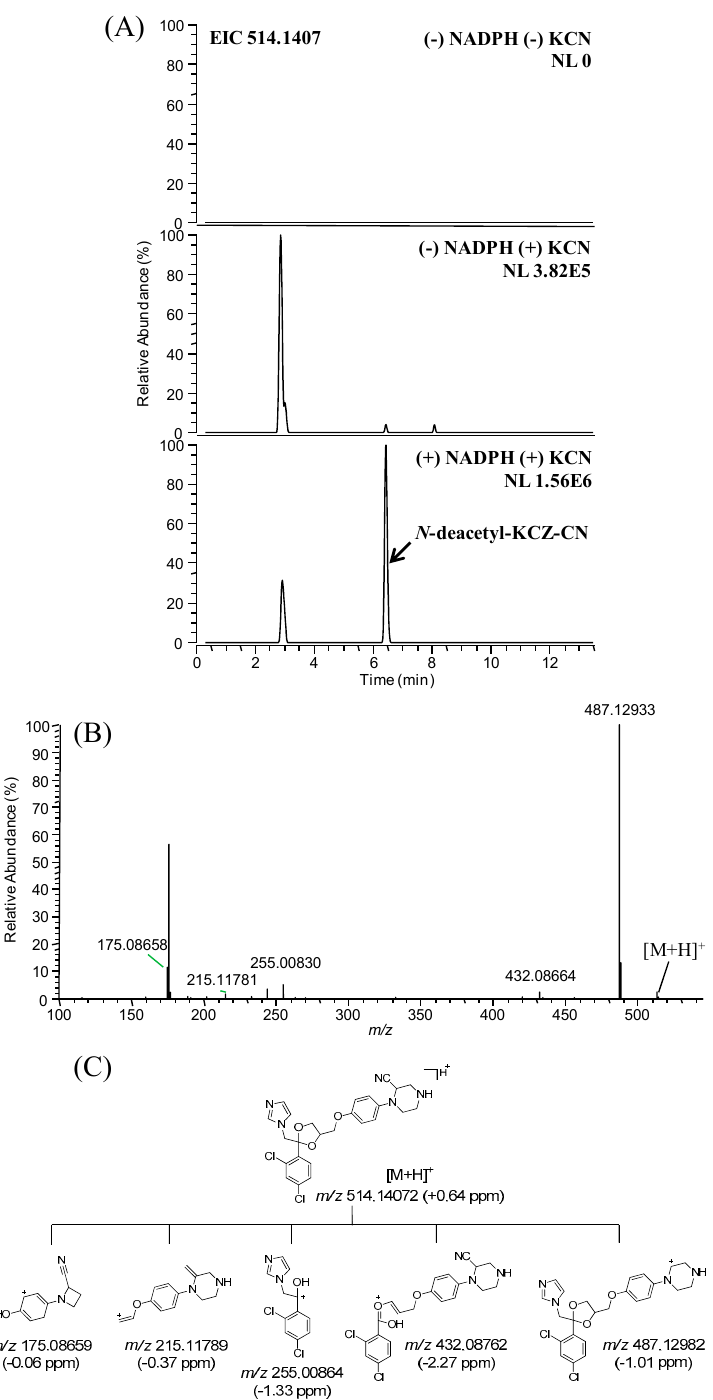
Figure 7. ( A ) Extracted ion chromatograms; ( B ) MS/MS spectrum; and ( C ) proposed fragment ions of cyanide adducts of N -deacetyl-ketoconazole.